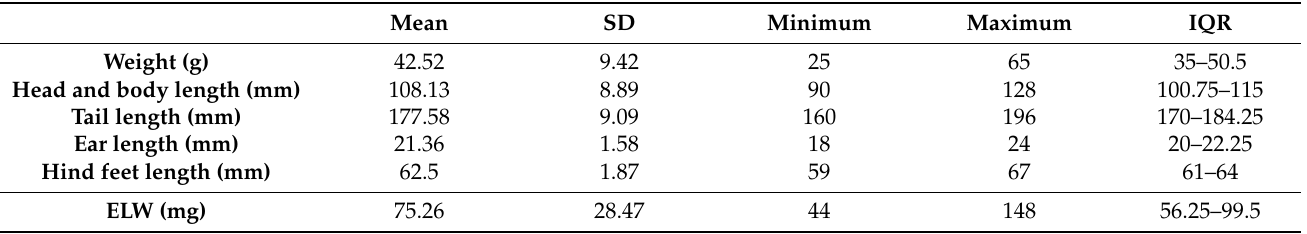
Table 1. Morphological measurements and eye lens weight (ELW) of the captured